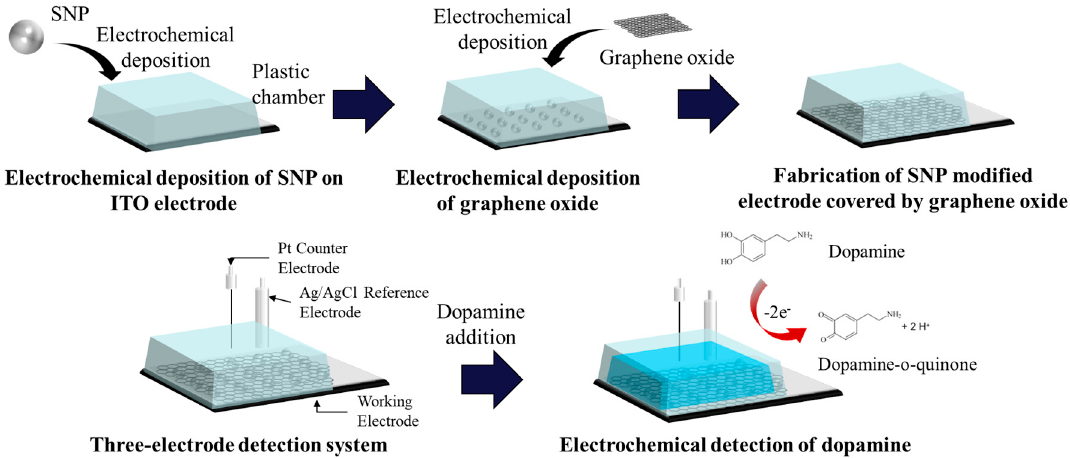
Figure 1. Schematic diagram of an SNP modified electrode covered by graphene oxide and the process of dopamine detection.